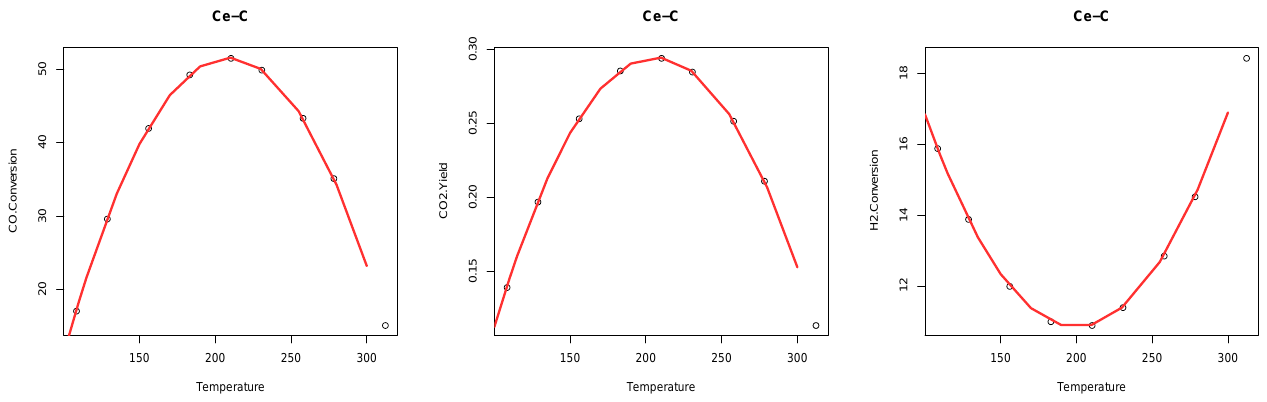
Figure 2. The interpolation of CO conversion (%), CO 2 yield, and H 2 conversion (%) using a polynomial equation of degree two is demonstrated for cube